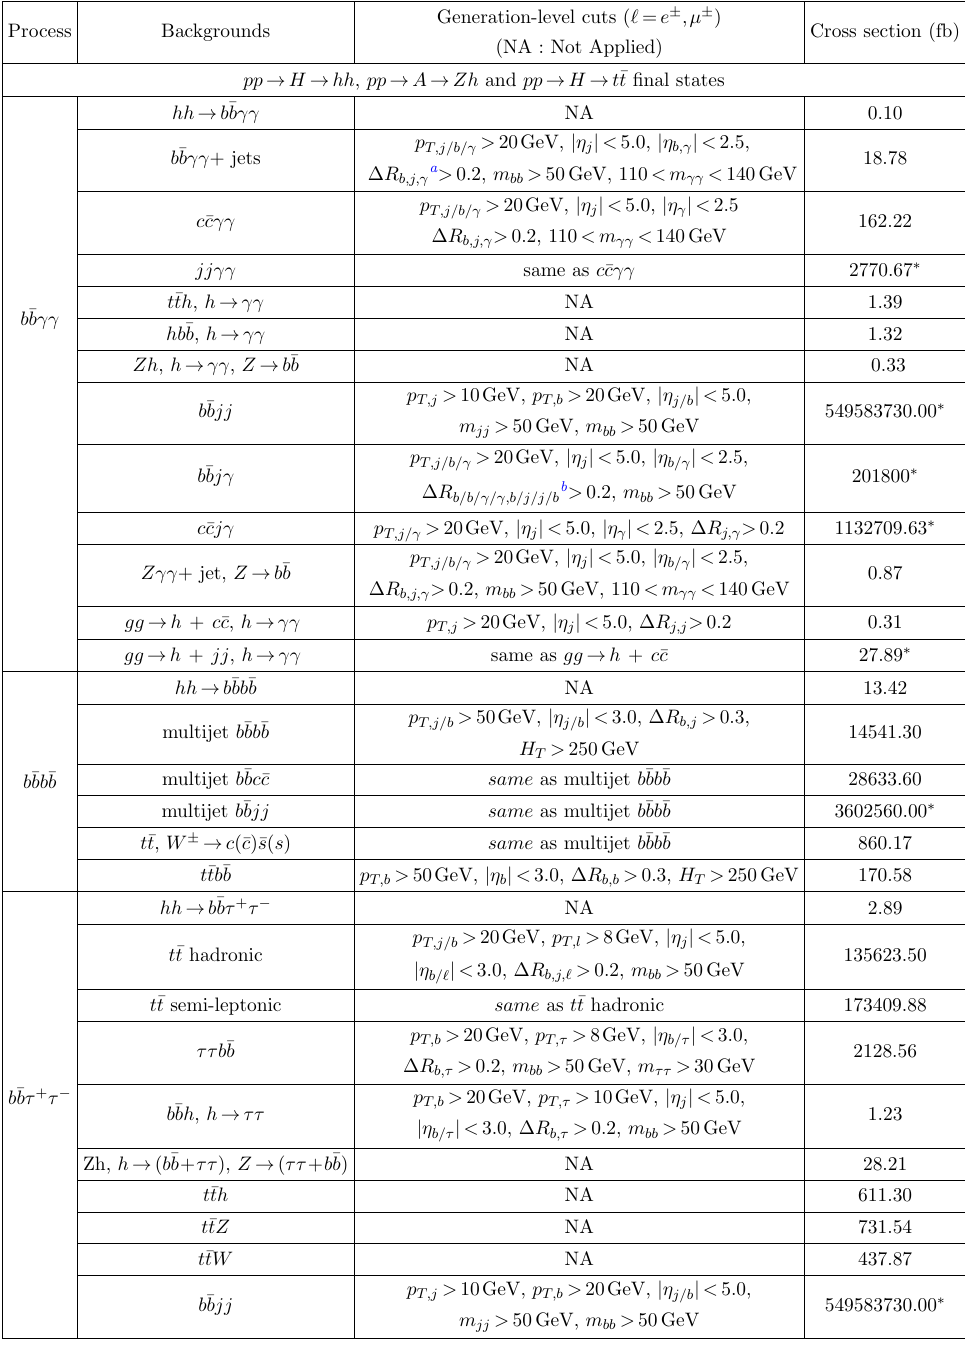
Table 19 . Generation level cuts and cross-sections for the various backgrounds used in the analyses. The backgrounds labelled with are multiplied by the fake rates before doing the analysis. The (cid:3) fake rates used are 0 : 05% [61] for j (cid:13) , 1 : 75%(average from the fake rate function) for j ! (cid:24) 0 : 35% [211] for j (cid:28) !